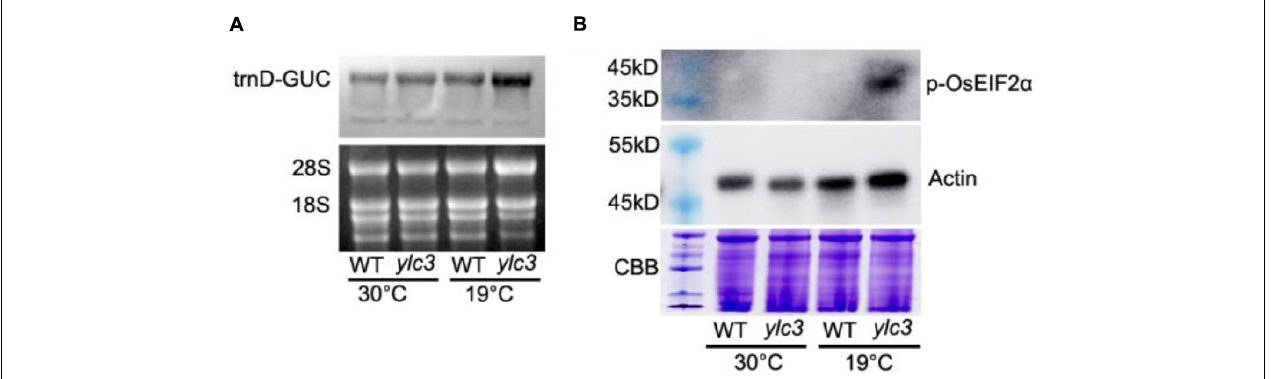
FIGURE 10 | Uncharged tRNA-Asp accumulation and phosphorylation of OsEIF2 α at different growth temperatures. (A) Uncharged tRNA-Asp levels in WT and ylc3 seedlings were analyzed by northern blot. The ethidium bromide-stained gel is shown as a loading reference. (B) Phosphorylation levels of OsEIF2 α in WT and ylc3 seedlings were monitored by immunoblot analysis. Upper and lower panels represent immunoblot results using antibodies against phosphorylated eIF2 α and actin, respectively. Coomassie Brilliant Blue (CBB) staining is shown as a loading reference. Protein size marker is